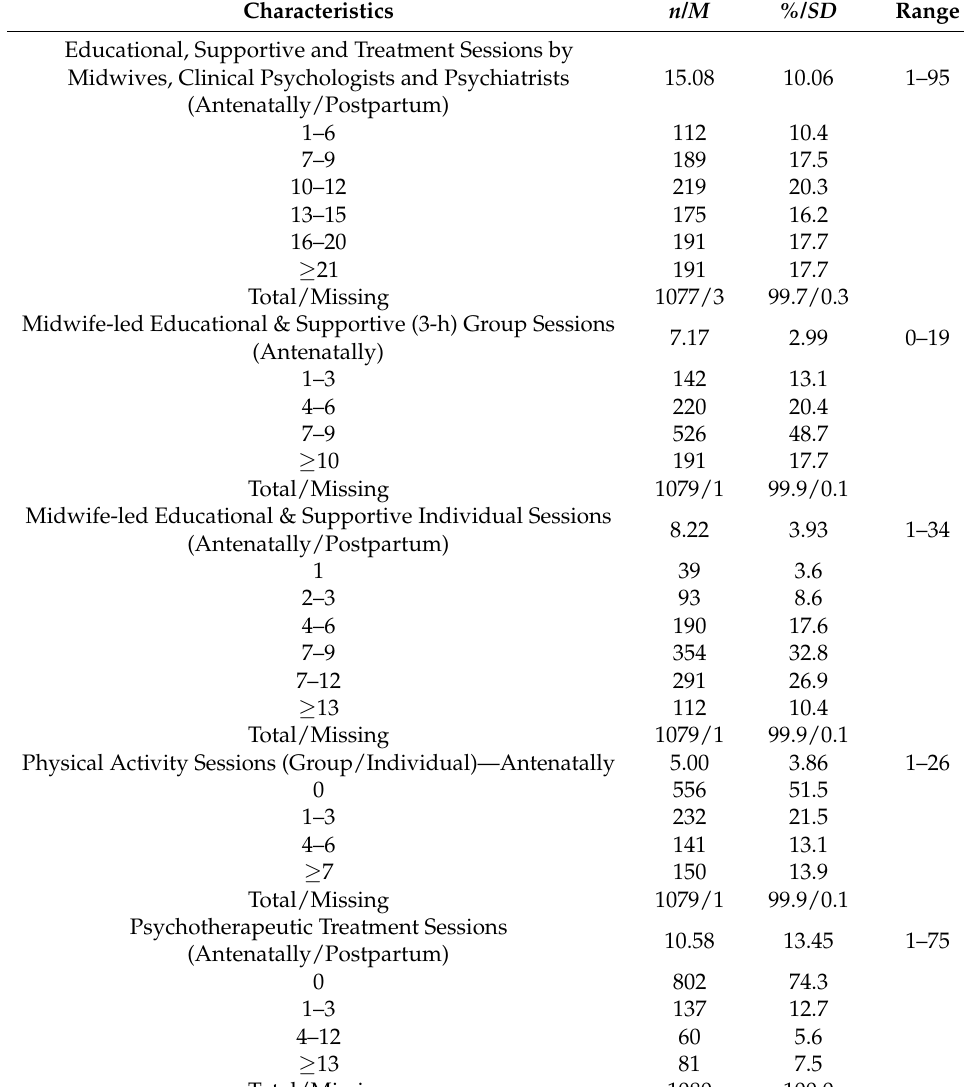
Table 2. The Midwifery and Psychosocial Intervention Program of the Day